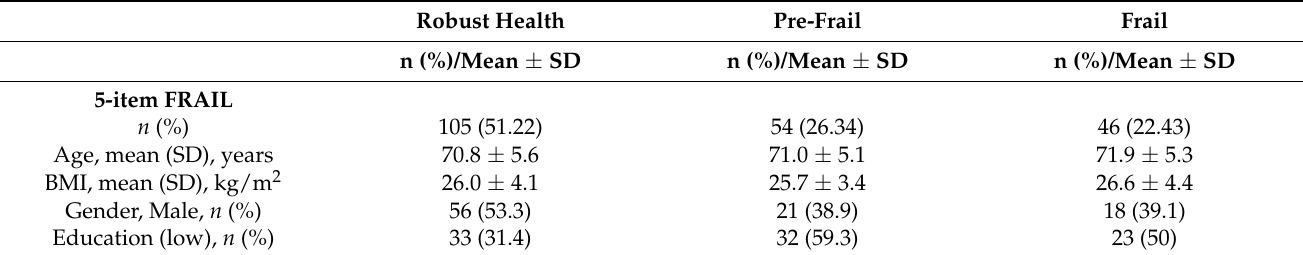
Table 1. Demographics of the participants according to their frail status ( n = 205). Robust Health